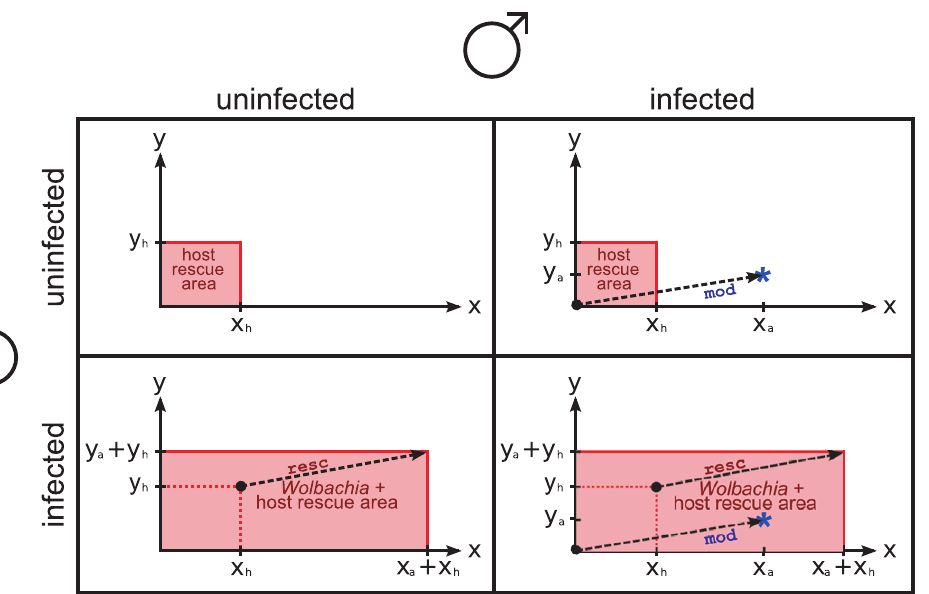
Figure 2. How the goalkeeper model’s two quantitative factors produce the known CI patterns. Females and males can either be uninfected or infected by Wolbachia . Two factors, x and y , are involved in the generation of CI. Wolbachia contribute x a to factor x and y a to factor y in equal amounts during modification in males and rescue in females (dashed arrows). Hosts contribute the net host contribution x h to factor x and y h to factor y in females only. Rescue occurs within the red areas, either due to hosts only (top row) or in combination with Wolbachia (bottom row). The blue asterisk shows the modification by Wolbachia (right column). CI occurs only if this blue asterisk does not lie within the rescue area because this implies that at least one of the factors x or y is produced at greater quantity in males than in females (top right). doi:10.1371/journal.pone.0019757.g002 PLoS ONE |